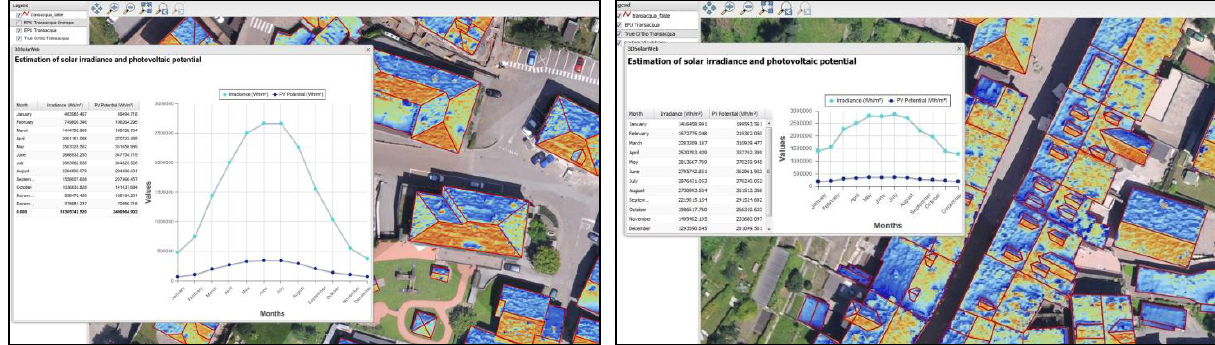
Figure 6: Example of the color coding web-based visualization of the estimated pixel-based solar irradiance and PV potential. The extracted building roof outlines are visualized on the true orthoimage. Clicking on a building pitch’s roof, the estimated irradiation and EPU curves are